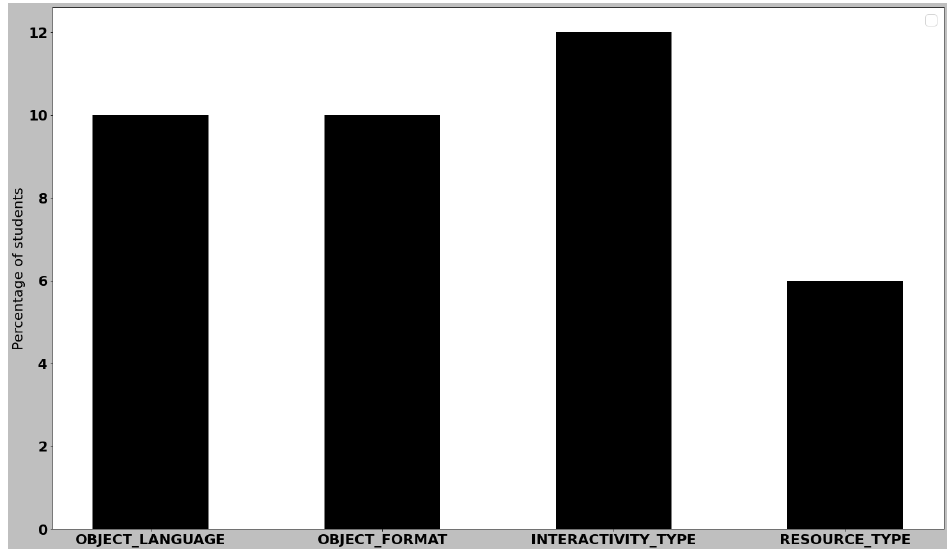
Figure 9. Average % of students that changed their declared